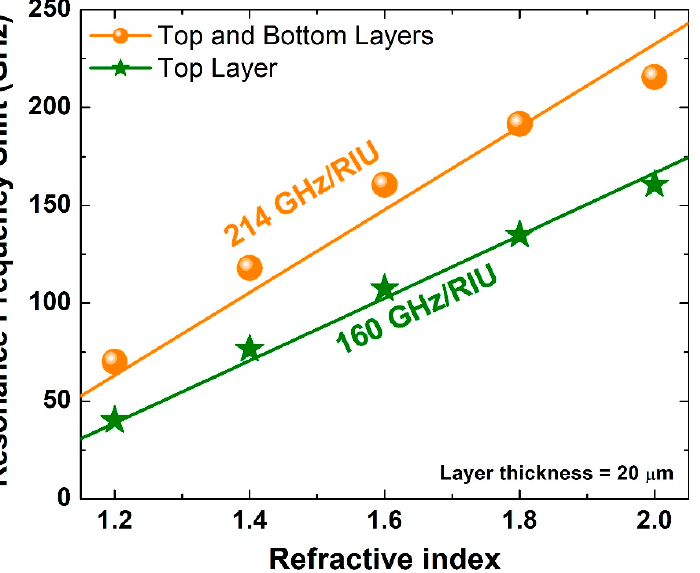
Figure 6. Asymmetric resonance frequency shift for two scenarios ( i ) top layer and ( ii ) top and bottom layers for different values of the refractive index between 1.2 and 2.0 with each sample layer thickness being 20 μ m.